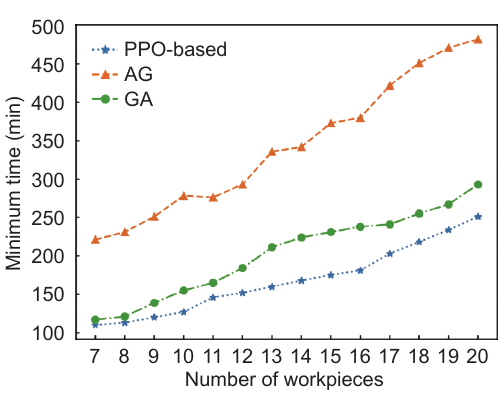
Fig. 3 Distribution 2 scheduling result.